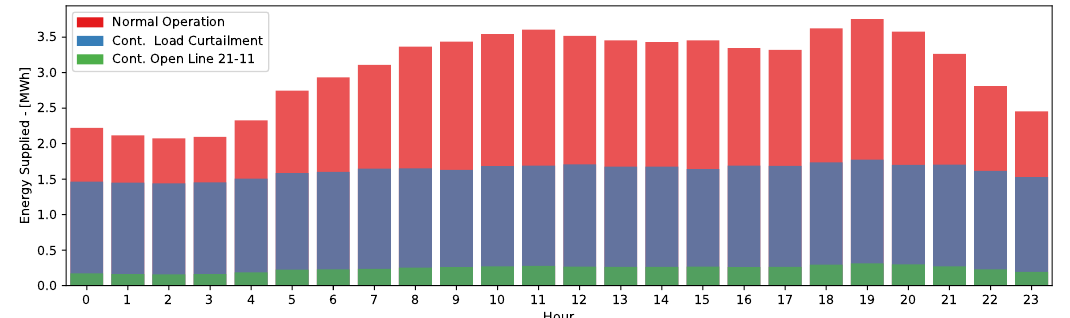
Figure 11. Energy Supplied during Thursday for normal operation, conventional method (Open line 21-11) and proposed method (Load Curtailment) for IEEE 33 bus distribution